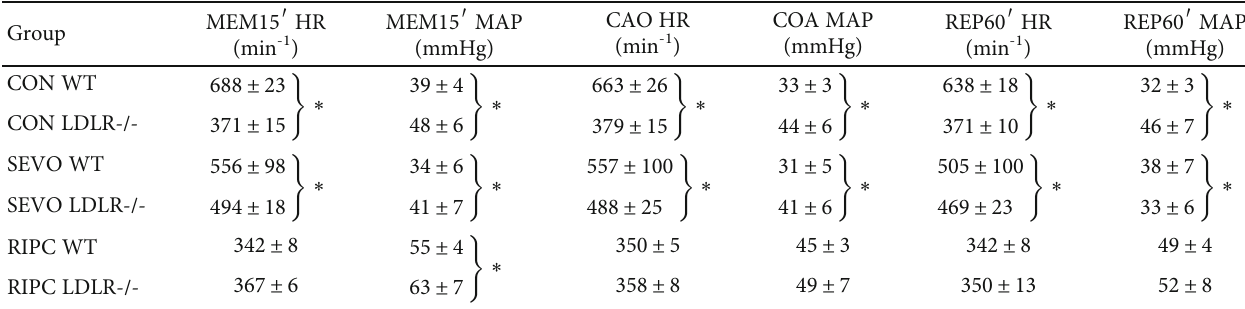
Table 2: Hemodynamic parameters of WT and LDLR-/- mice with and without preconditioning. MEM15 ′ Group